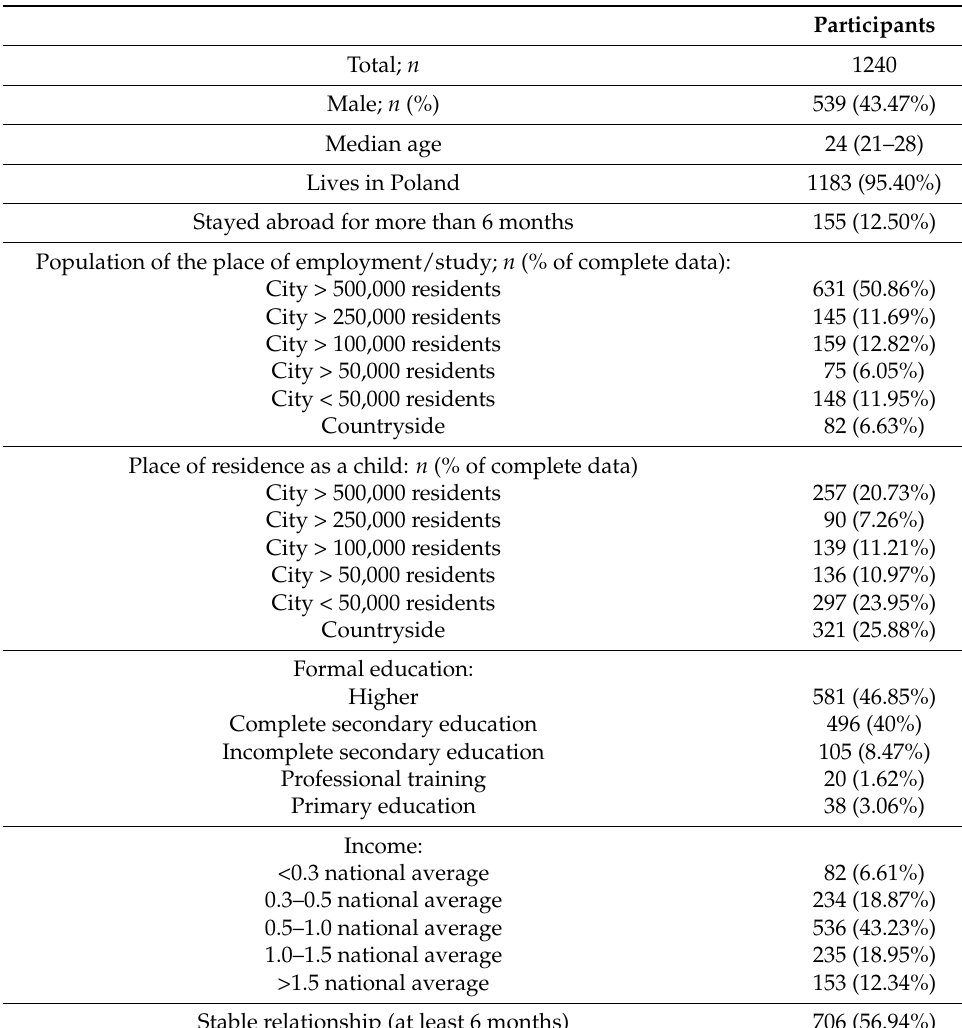
Table 1. Study group characterization ( n =